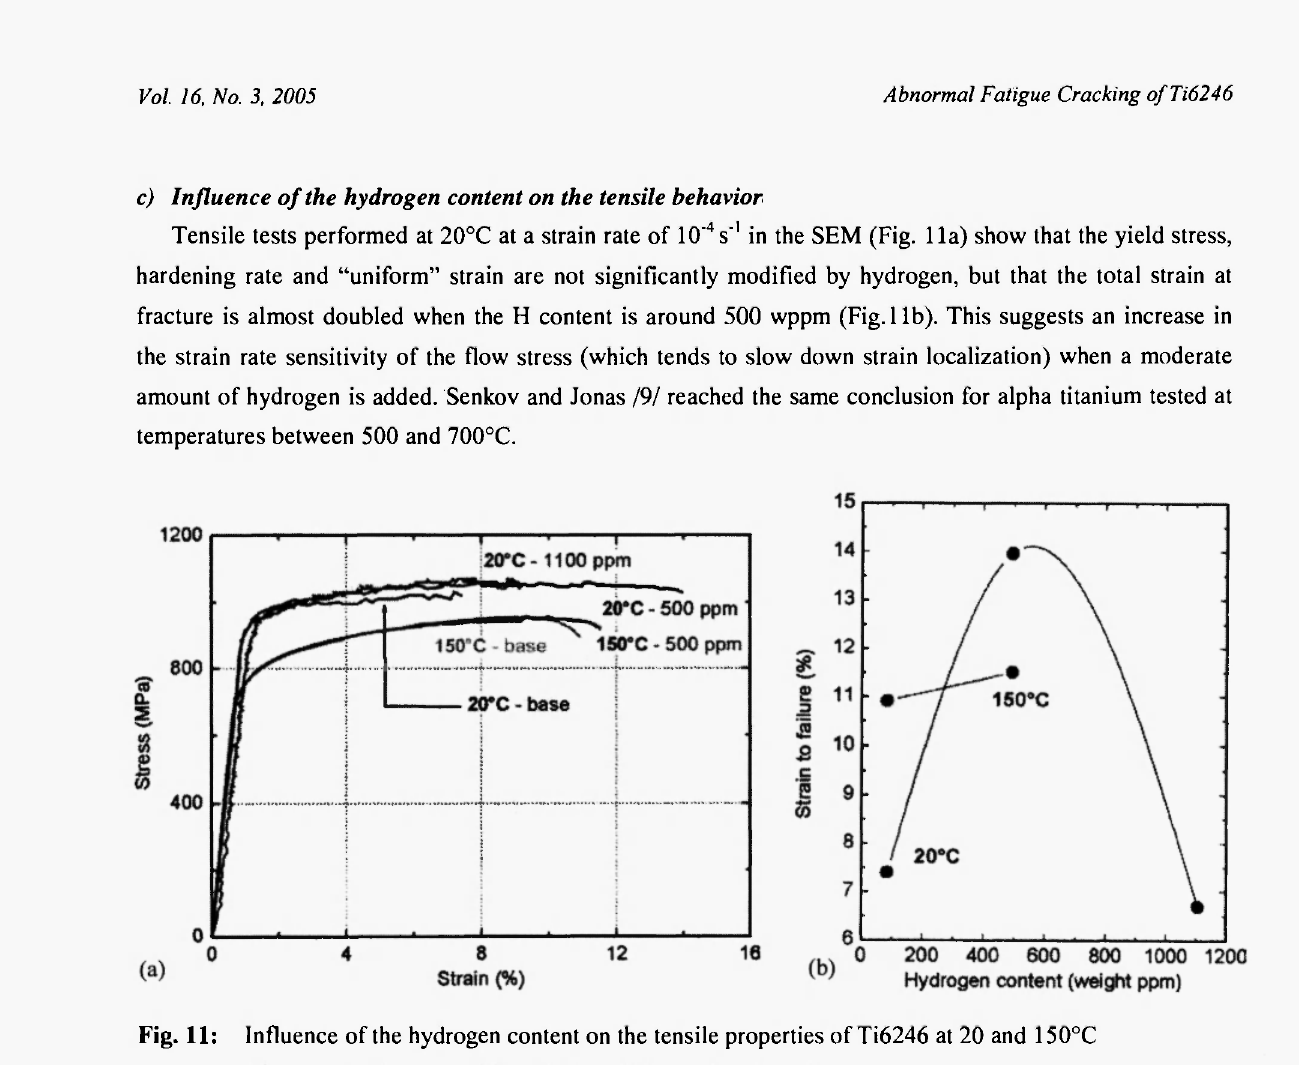
Fig. 11: Influence of the hydrogen content on the tensile properties of ΤΪ6246 at 20 and 1 50°C (a) stress-strain curves (b) evolution of the total strain at